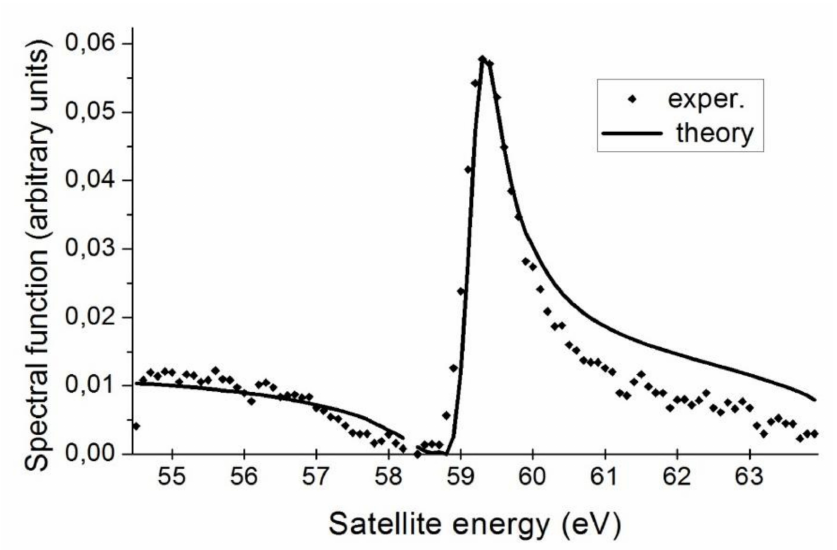
(cid:0) 3 (cid:1) (cid:0) 2 (cid:1) S S 3 s of Ne photoionization (solid line),